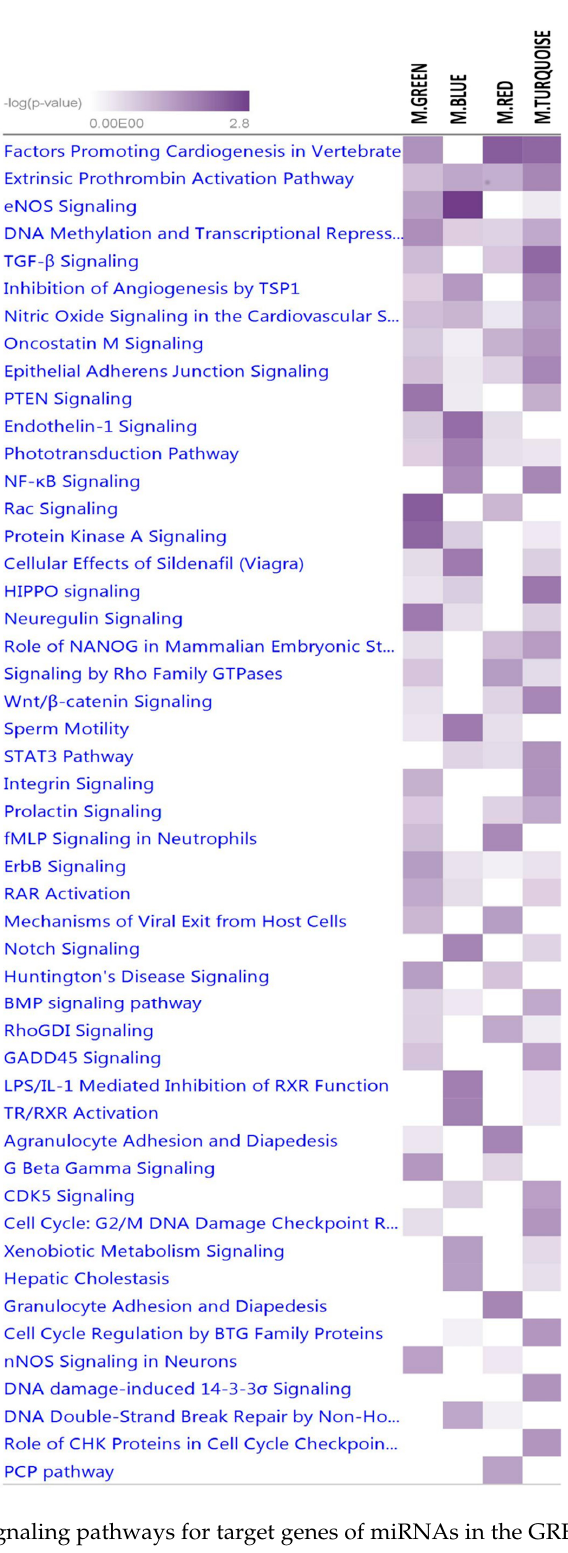
Figure 5. Enriched signaling pathways for target genes of miRNAs in the GREEN, BLUE, RED and TURQUOISE modules.